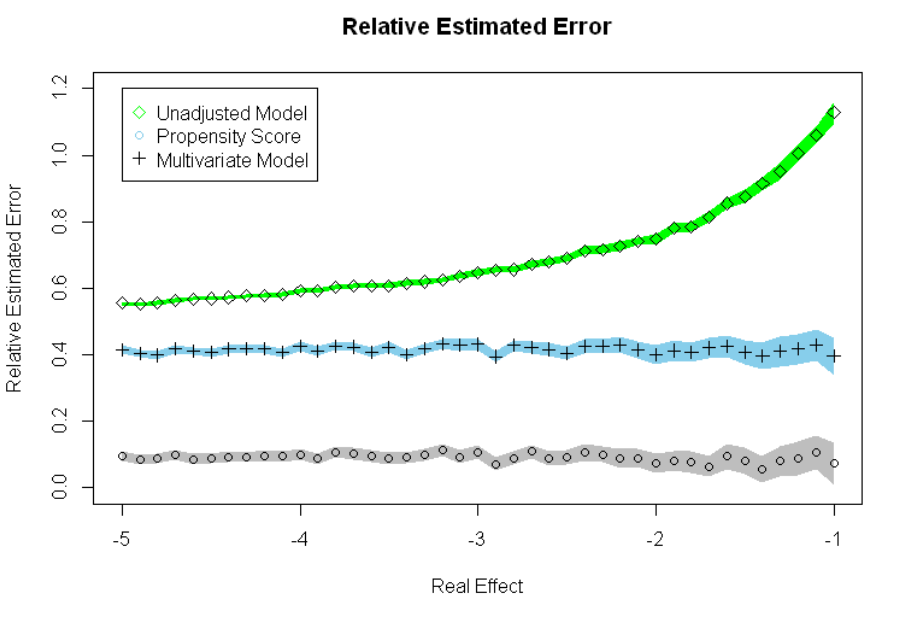
Figure 3. Comparison of Relative Real Treatment Effect Estimation Error with the Unadjusted Model, Multivariate Model and Propensity Score Matching